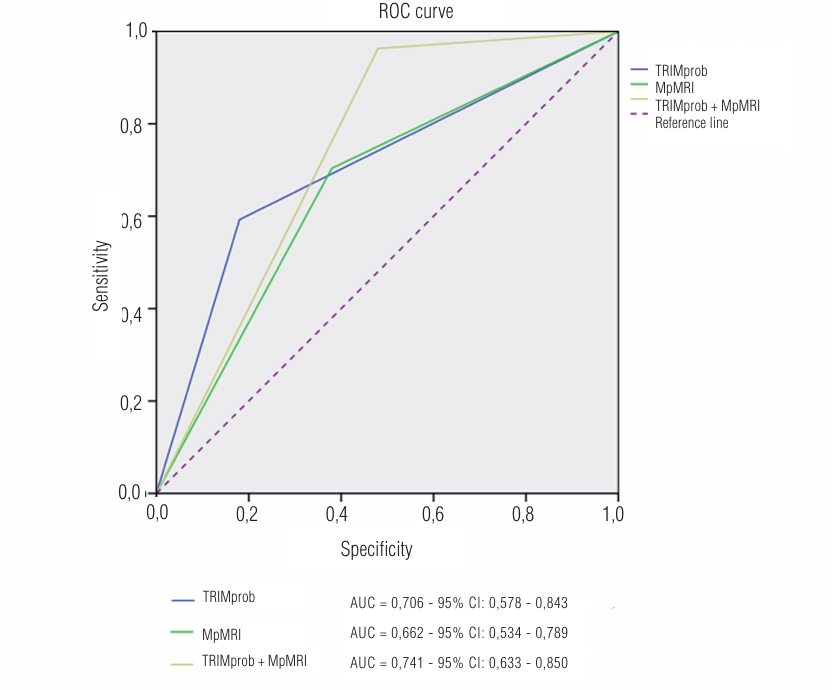
Figure 2 - ROC curves characteristics: results of TRIMprob, mpMRI and combination of both methods in the diagnosis of prostate cancer in 77 patients submitted to prostate